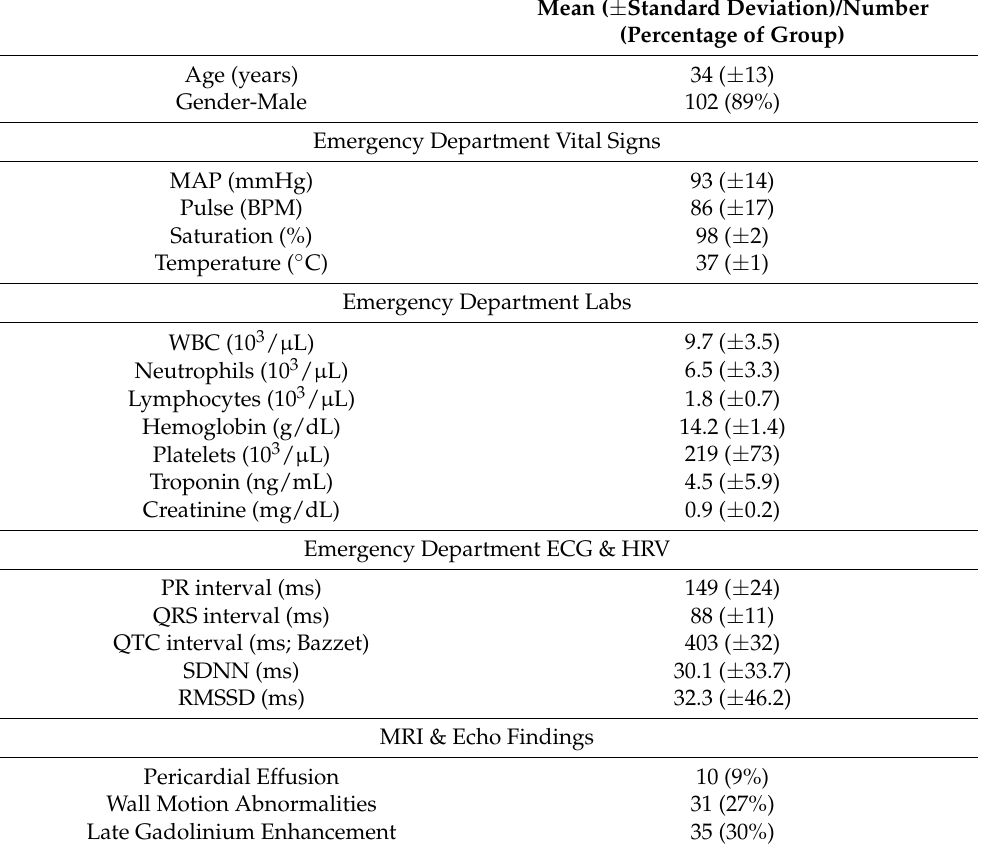
Table 1. Study population characteristics ( n =